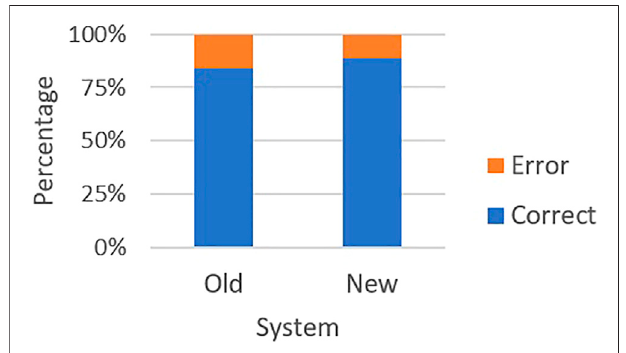
FIGURE 5 | Errors by system. The red bars indicate errors and the blue bars indicate correct